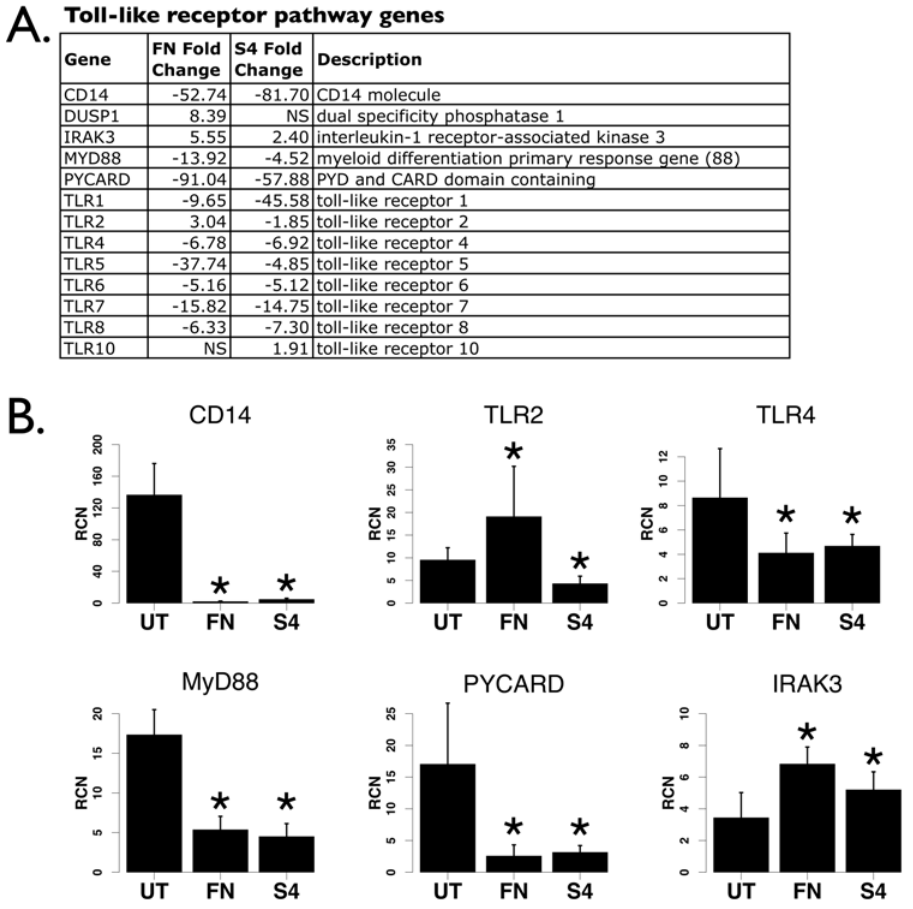
Figure 3. Toll-like receptor pathway genes affected by Francisella . A. List of TLR pathway genes from the microarray analysis. Fold changes of genes not statistically different are denoted ‘‘NS’’. B. Real-time PCR analyses of CD14, TLR2, TLR4, MyD88, PYCARD and IRAK-M from human PBM infected with either F. novicida (‘‘FN’’) or Schu S4 (‘‘S4’’) at an MOI of 100 for 24 hours (n=8). ‘‘RCN’’ is Relative Copy Number for the Y axis. Asterisks denote statistical significance (p # 0.05) versus uninfected.